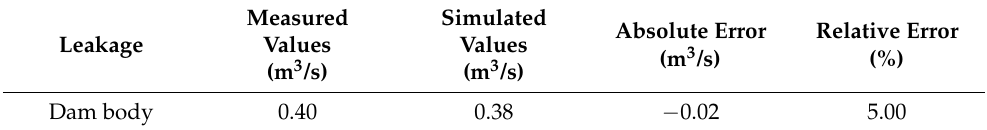
Table 6. Comparison between the simulated and measured values of the dam body leakage.